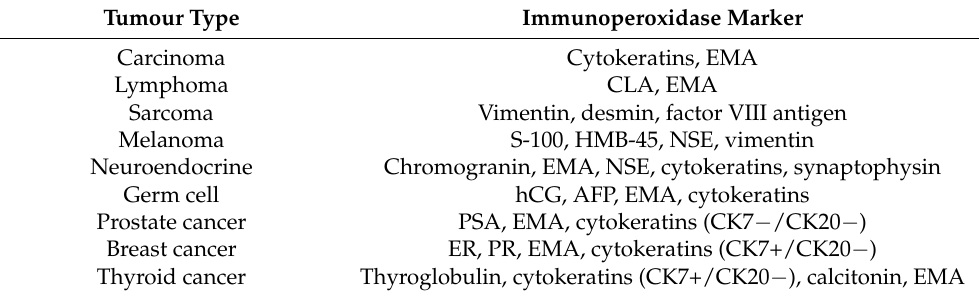
Table 2. Immunohistochemistry tests for investigating CUP.